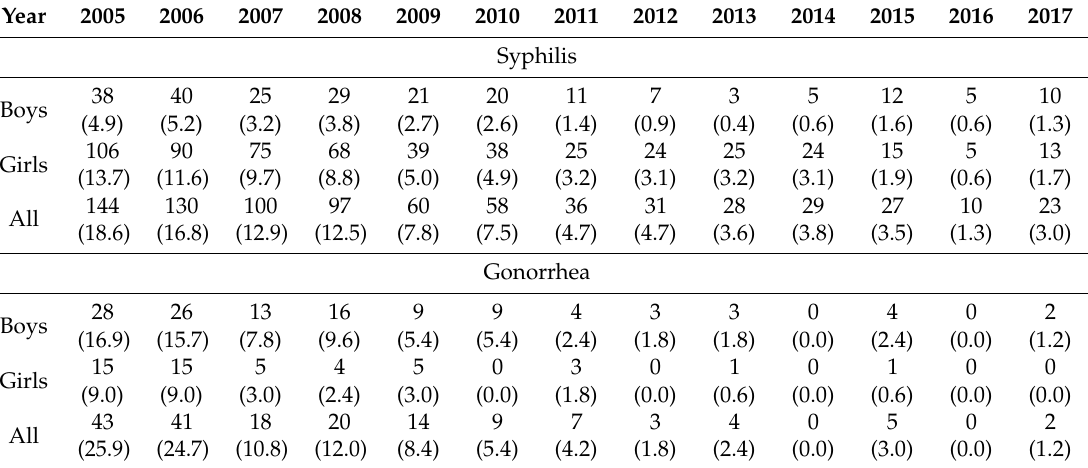
Table 2. Number of syphilis and gonorrhea cases (%) by gender in the studied time